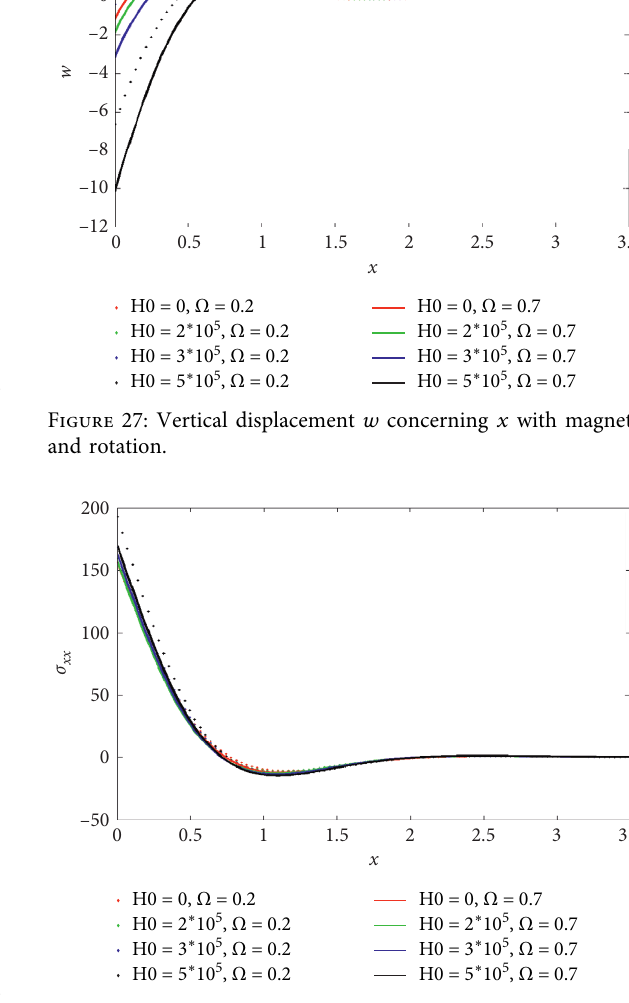
Figure 28: Stress σ x with magnetic and xx concerning